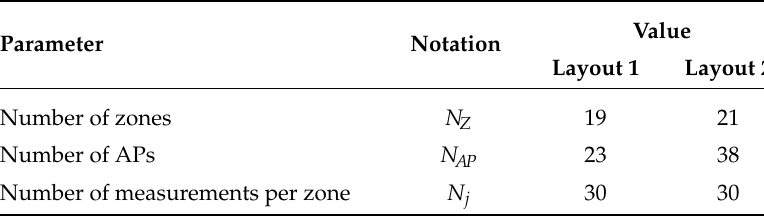
Figure 4. The Living Lab in ( a ) and the first floor of the statistical and operational research department in ( b ) at the University of Technology of Troyes, France. Table 1. Experimental setup